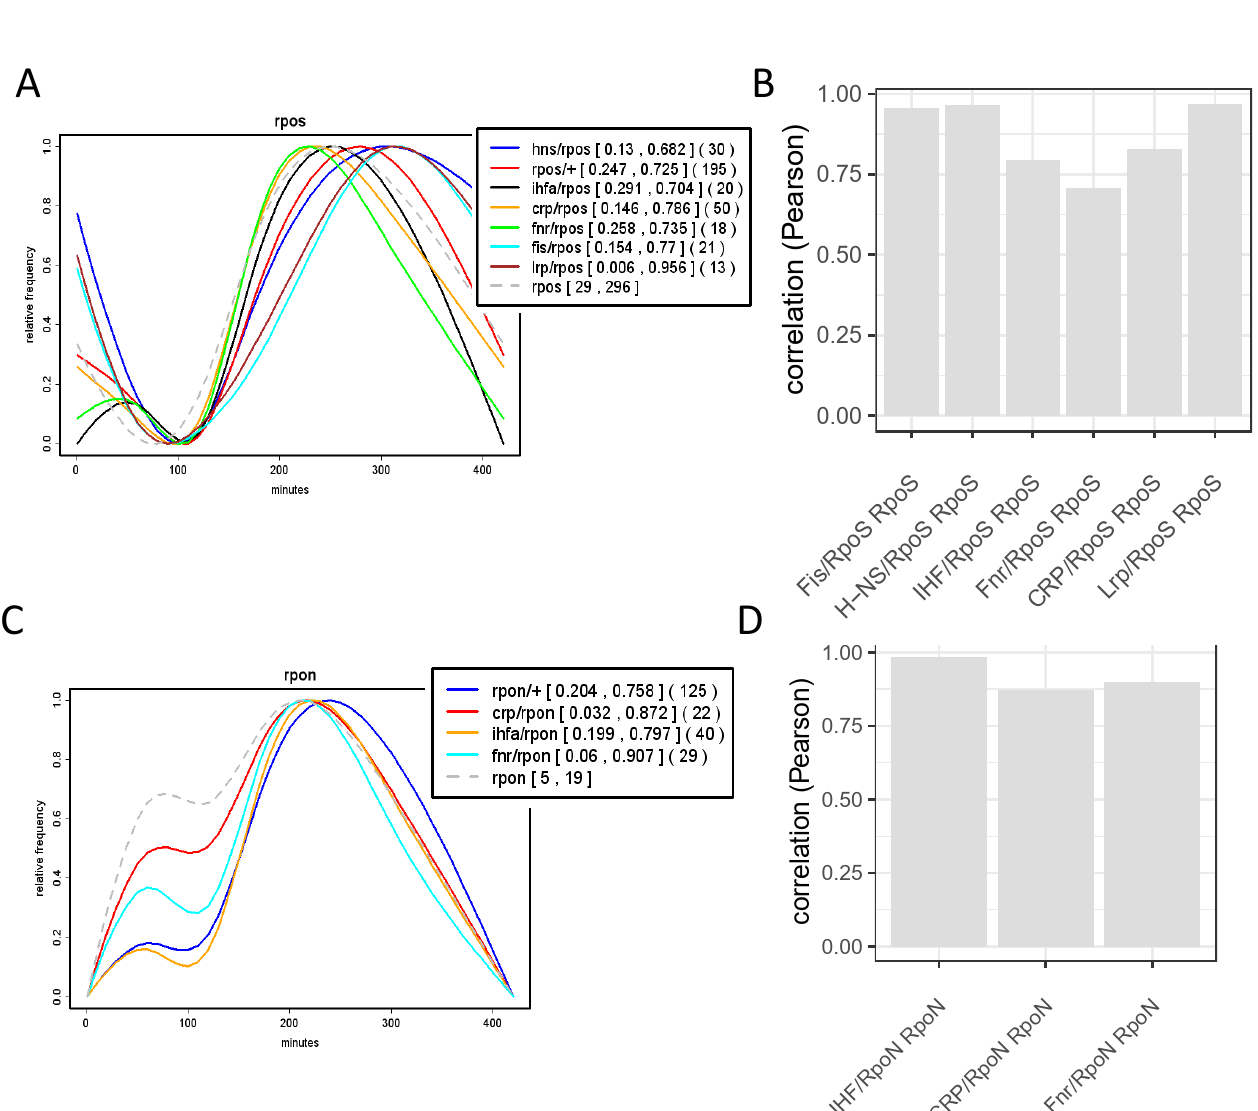
Figure 7. Correlation between the temporal expression of ASF regulons and couplons. ( A ). Growth phase-dependent expression of the RpoS regulon and RpoS/NAP couplons. The colored curves were computed as described in the legend to Figure 6. Abscissa—time in minutes after inoculation of cells in fresh growth medium; ordinate—relative frequency of each class of genes as indicated in the inset. ( B ). Pearson correlations (ordinate) between the temporal expression of RpoS regulon, RpoS/NAP and RpoS/global TF (CRP and Fnr) couplons (as indicated on the abscissa). ( C , D ). The same as in ( A , B ), but for the RpoN sigma factor. Note the high positive correlation between the temporal expression of both ASF (RpoS and RpoN) regulons and that of NAP/ASF and global TF/ASF couplons. The expression patterns of rpoS and rpoN genes (in A and C , respectively) are indicated by grey dashed lines. rpoS/+ and rpoN/+ respectively indicate the RpoS and RpoN regulons. Numbers in squared brackets indicate the minimum and maximum of the regulon/couplon before normalization to [0;1]. Note, that these numbers are averages of the regulon couplon genes already normalised individually to [0;1]. Numbers in round brackets indicate the number of genes involved in the respective regulon or couplon The experimental procedure was as described in the legend to Figure 6 (plots A and C , data from